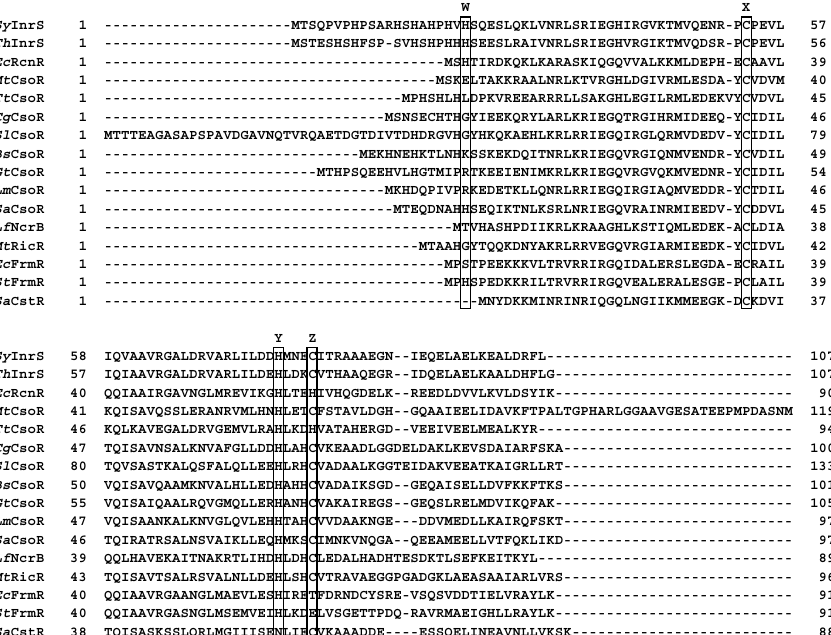
Figure 1. PROMALS3D [19] multiple sequence alignment of the known members of the RcnR/CsoR family. Synechocystis PCC 6803 InrS, Sy InrS; Thermosynechococcus sp. NK55a InrS, Th InrS; Escherichia coli RcnR, Ec RcnR; Mycobacterium tuberculosis CsoR, Mt CsoR; Thermus thermophilus CsoR, Tt CsoR; Corynebacterium glutamicum CsoR, Cg CsoR; Streptomyces lividans CsoR, Sl CsoR; Bacillus subtilis CsoR, Bs CsoR; Geobacillus thermodenitrificans CsoR, Gt CsoR; Listeria monocytogenes CsoR, Lm CsoR; Staphylococcus aureus CsoR, Sa CsoR; Leptospirillum ferriphilum NcrB, Lf NcrB; Mycobacterium tuberculosis RicR, Mt RicR; Escherichia coli FrmR, Ec FrmR; Salmonella typhimurium (strain SL1344) FrmR, St FrmR; Staphylococcus aureus NCTC 8325, Sa CsrT. The CsoR/RcnR W–X–Y–Z fingerprint residues have been highlighted by black boxes.